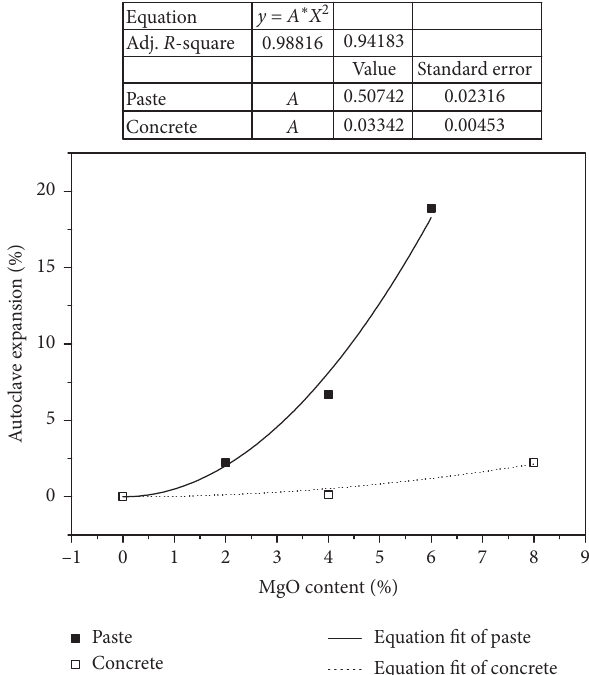
Figure 1: Relationship between autoclave expansion and reactive magnesium oxide